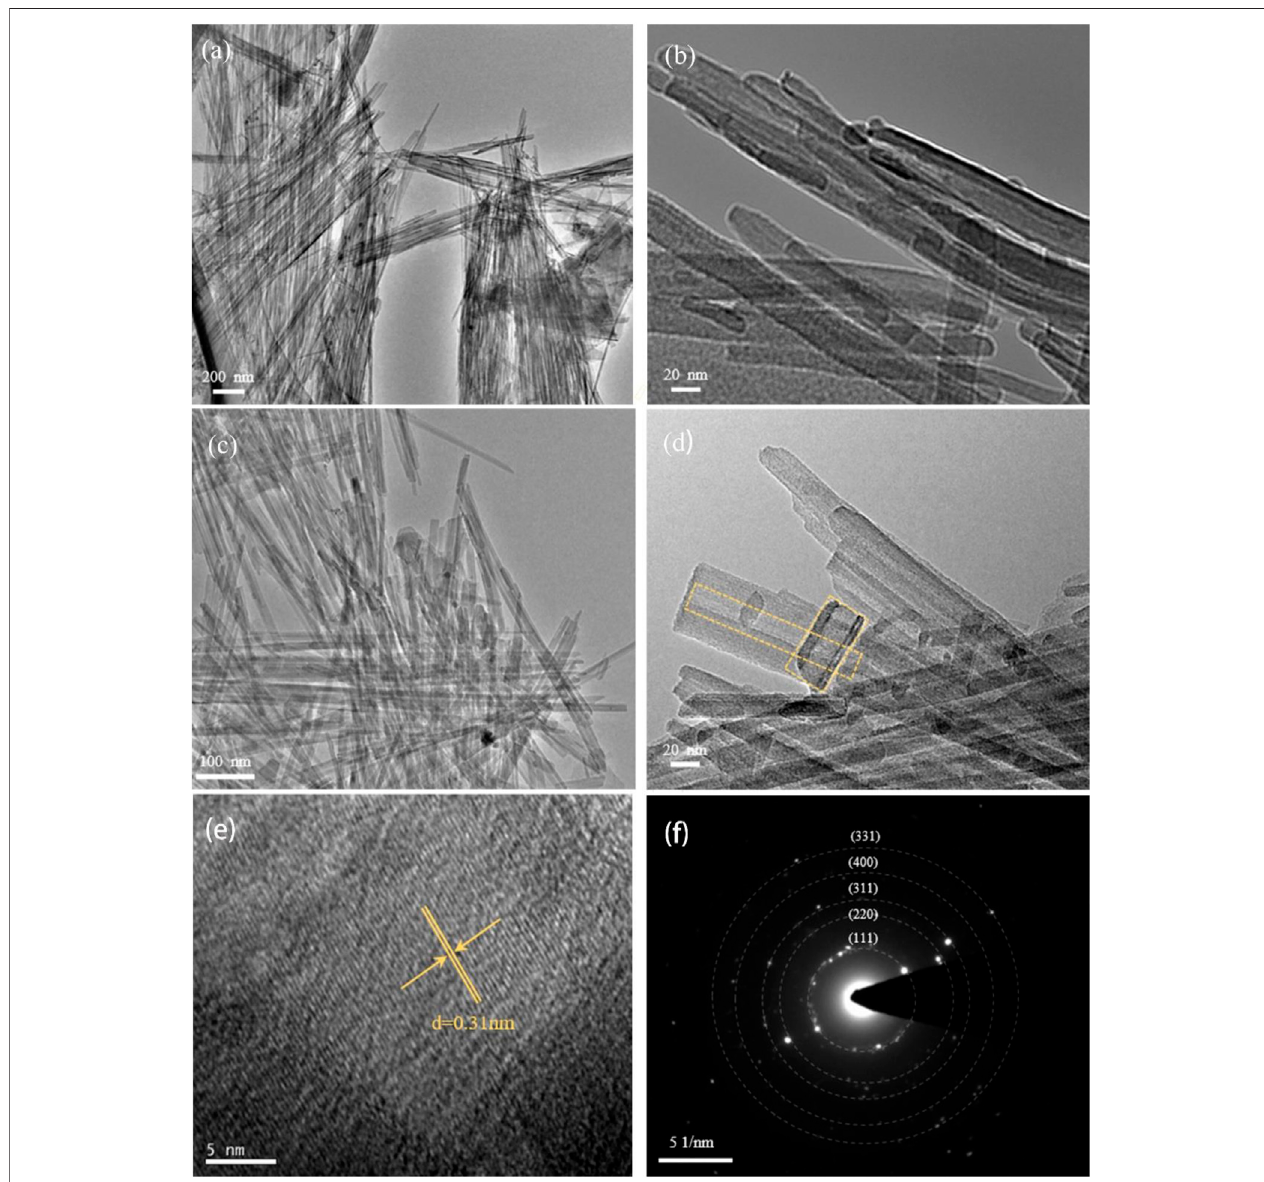
FIGURE3|(A) TEM and (B) magni fi ed TEMofnatural sepiolite showing 1Dnano fi ber morphology.MorphologicalcharacterizationofSNF, (C) TEM, (D) magni fi ed TEM, (E) HRTEM, and (F) the corresponding SAED pattern (Yellow ring marks material pores).